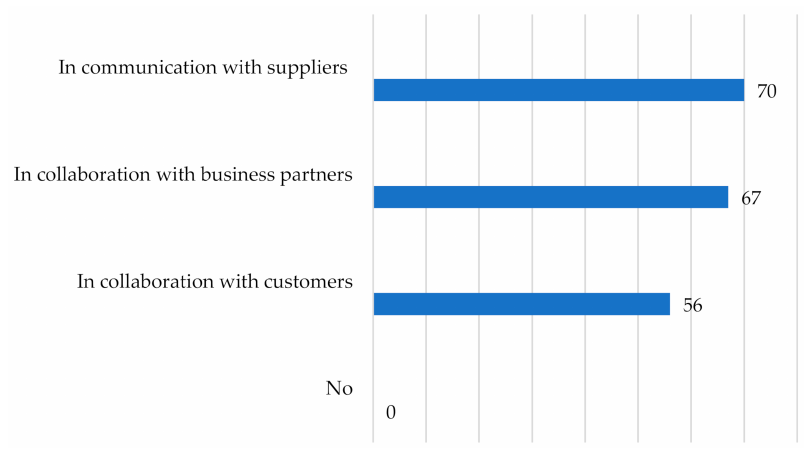
Figure 9. External processes where there is a need to apply the pillars of Industry 4.0.